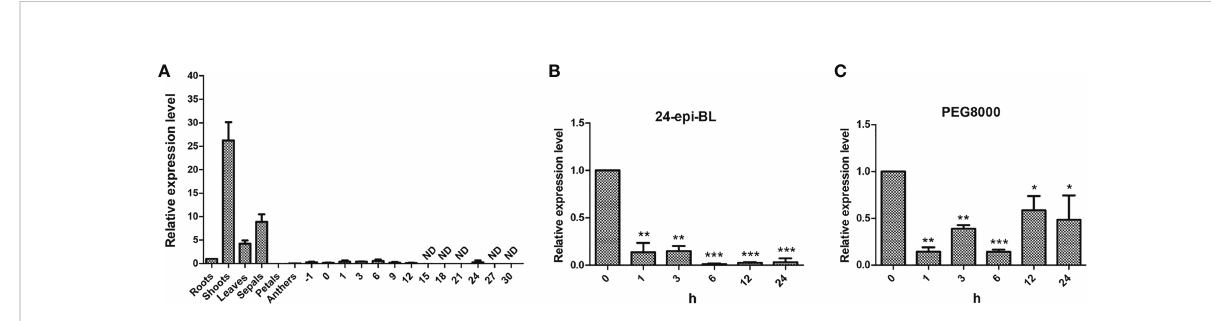
FIGURE 3 The expression pro fi ling analysis of GhBEE3-Like gene. (A) Tissue expression analysis of GhBEE3-Like in cotton. -1, ovules at -1 days post-anthesis (dpa); 0, ovules at 0 dpa; 1, 3, 6, 9, 12, 15, 18, 21, 24, 27 and 30, fi bres at 1dpa, 6 dpa, 9 dpa, 12 dpa, 15 dpa, 18 dpa, 21 dpa, 24 dpa, 27 dpa and 30 dpa. (B) The expression analysis of GhBEE3-Like in response to 24-epi-BL (an active BR substance). (C) The expression analysis of GhBEE3-Like in response to PEG8000 (drought simulation). Error bars were conducted with three independent biological replicates. 0 h was used as a control